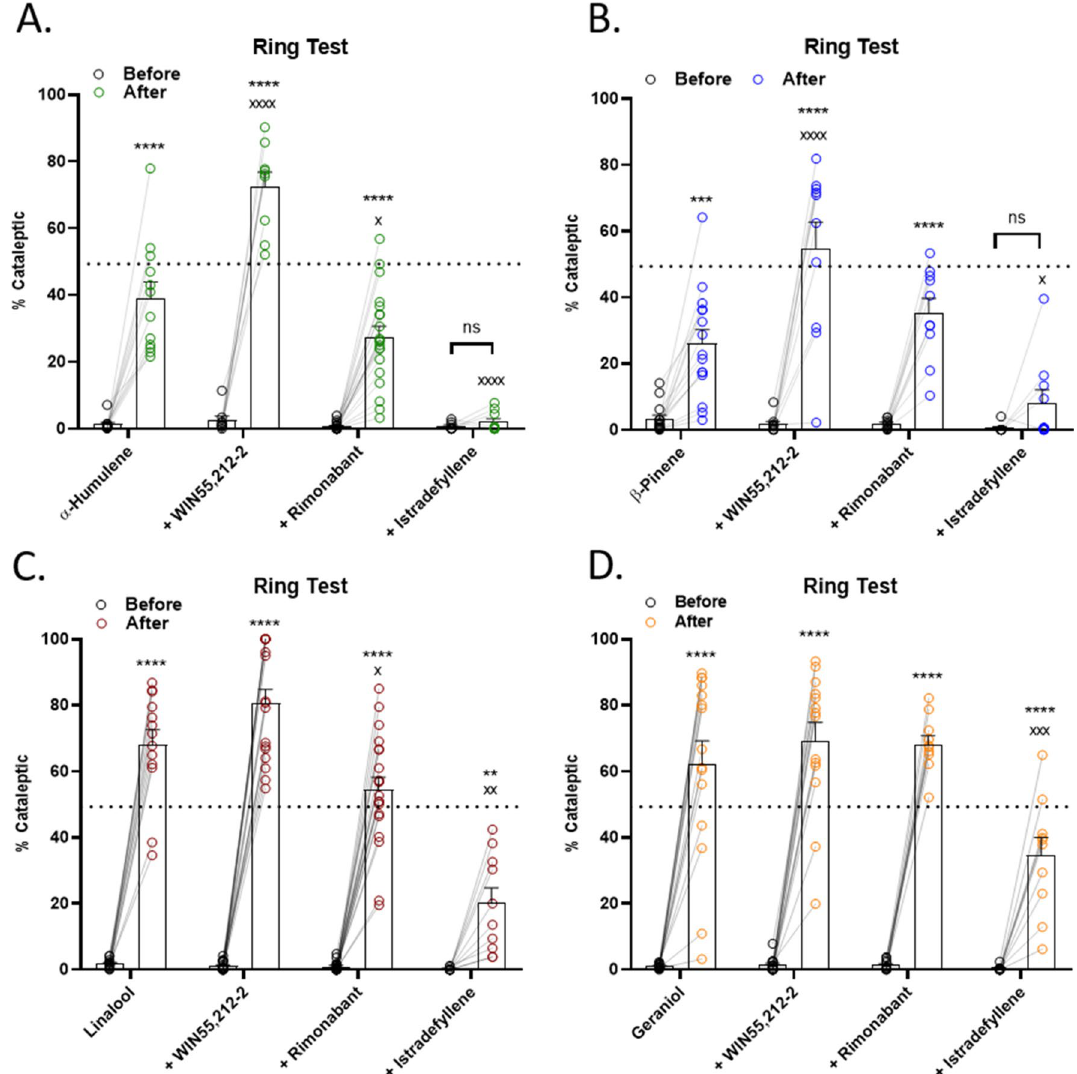
Figure 4. Terpene Induced Catalepsy is Partially Mediated by CB1, Strongly Mediated by A2a, and is Partially Additive with Cannabinoid. Mice were baselined in the ring test for 5 min, injected with 200 mg/kg terpene alone, combined with 5.6 mg/kg WIN55,212-2, or after pretreatment with 10 mg/kg rimonabant or 10 mg/kg istradefyllene. After 15 min, mice were tested in the ring test again for 5 min. ( A ) α-Humulene, ( B ) β-Pinene, ( C ) Linalool and ( D ) Geraniol. Data represents the mean ± SEM of % catalepsy (n = 10–20/group). Statistics analyzed via RM two-way ANOVA, Tukey’s post hoc; ** p < 0.01, *** p < 0.001, **** p < 0.0001, not significant (ns) compared to baseline; x p < 0.05, xx p < 0.01, xxx p < 0.001, xxxx p < 0.0001 compared to terpene post-treatment. The dashed line represents the cataleptic response to 5.6 mg/kg WIN55,212-2 alone, taken from Fig.